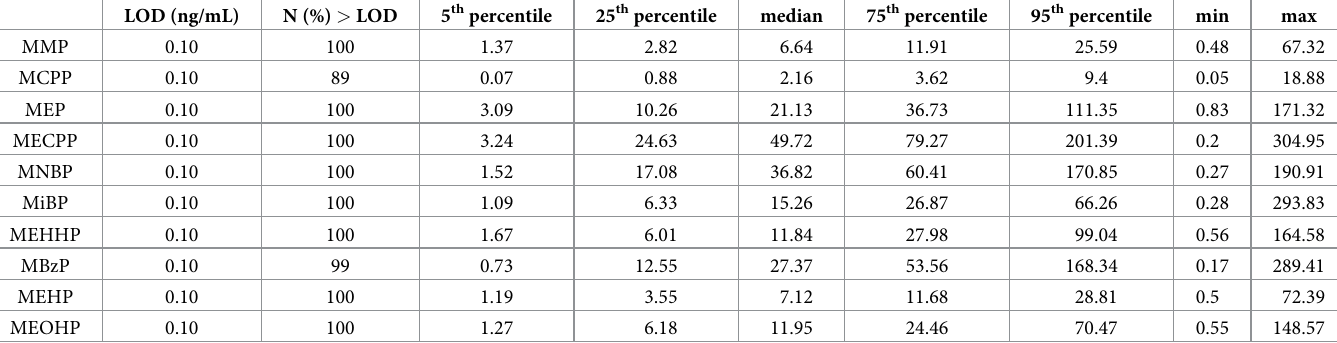
Table 3. Distribution of specific gravity-adjusted phthalate concentrations measured in the cohort (ng/mL).